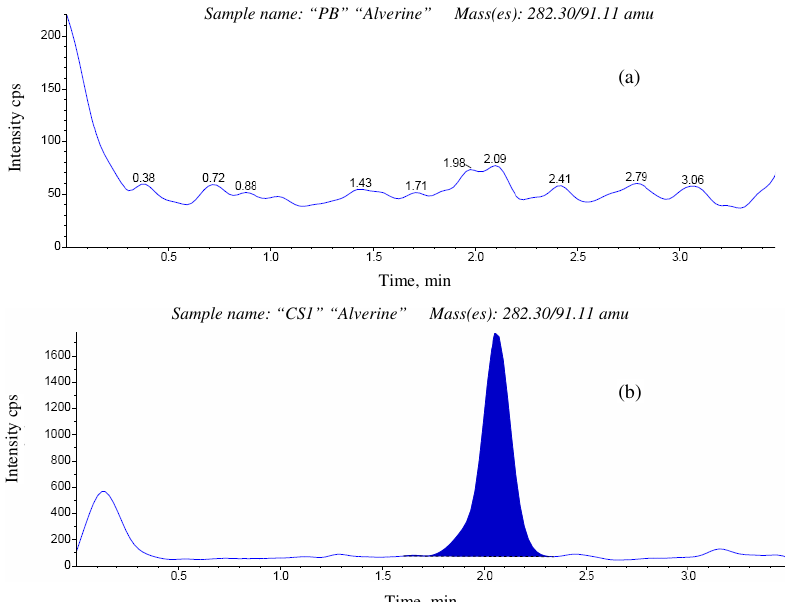
Figure 5. MRM chromatograms obtained from human plasma blank (a) and plasma spiked (b) with ALV at lower limit of quantification (0.060